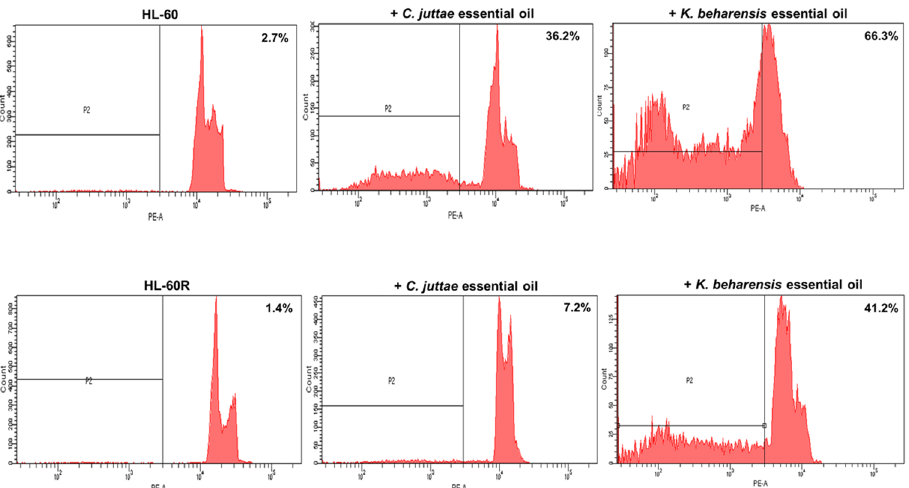
Figure 6. A representative example of flow cytometry analysis of cell death and cell cycle in the HL-60 and HL-60 R cells treated with 40 μg/mL concentrations of C. juttae or K. beharensis essential oils.